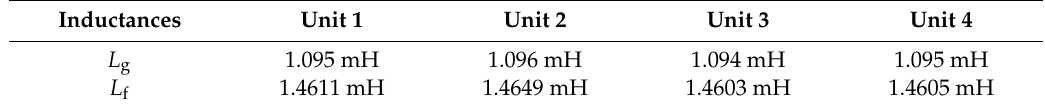
Table 2. Simulated inductances of the HSTT with